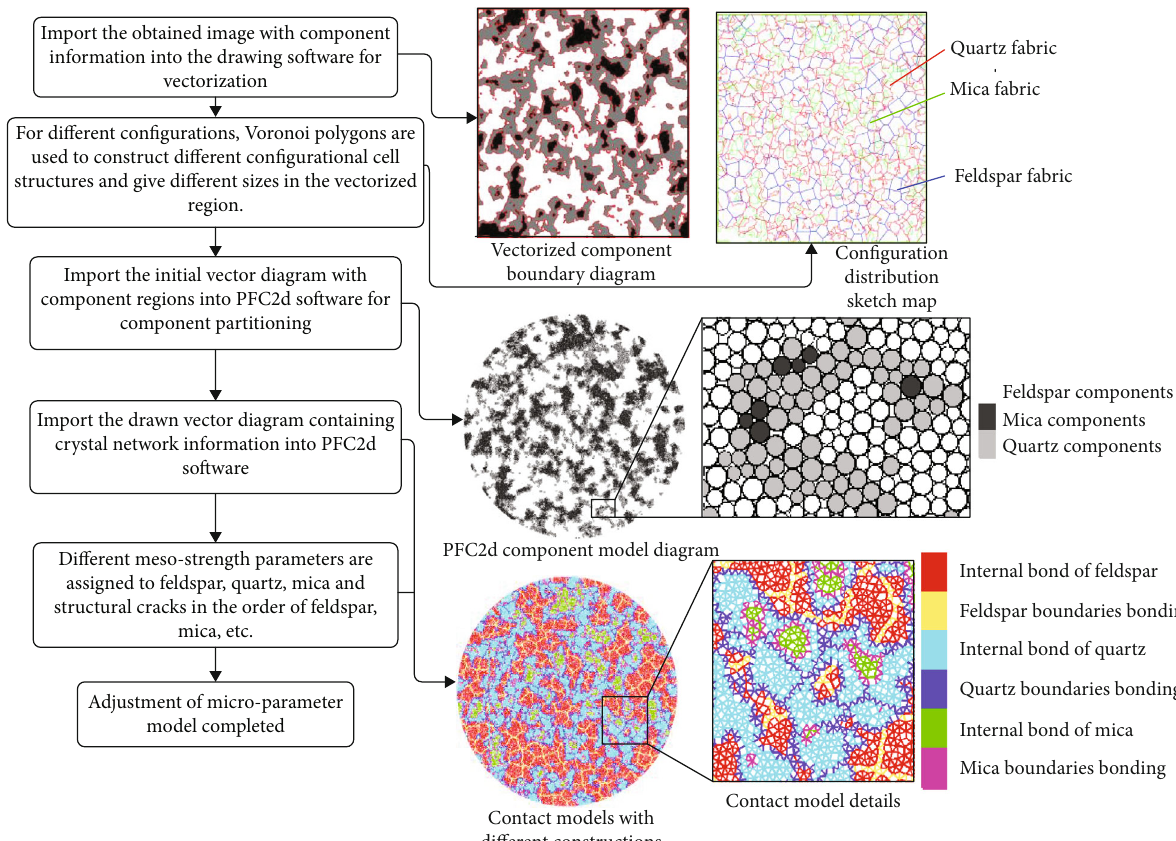
Figure 6: Generation process of SCGM